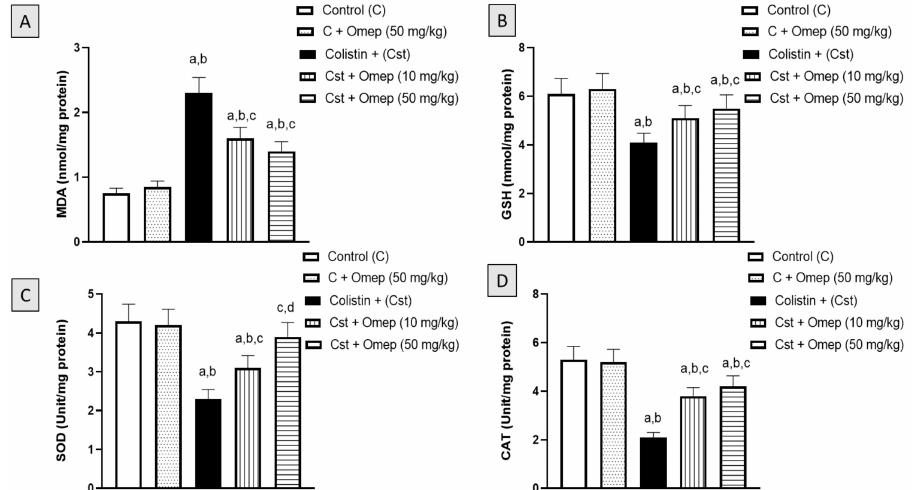
Figure 3. Effect of omeprazole on oxidative status in colistin-induced nephrotoxicity in rats. ( A ): MDA, ( B ): GSH, ( C ): SOD, ( D ) CAT. Data are shown as M ± SD ( n = 6). Omeprazole = Omep; Colistin = Cst. a: Significantly different from Control at p < 0.05; b: Significantly different from Omep (50 mg/kg) at p < 0.05; c: Significantly different from Cst at p < 0.05; d: Significantly different from Cst + Omep (10 mg/kg) at p <